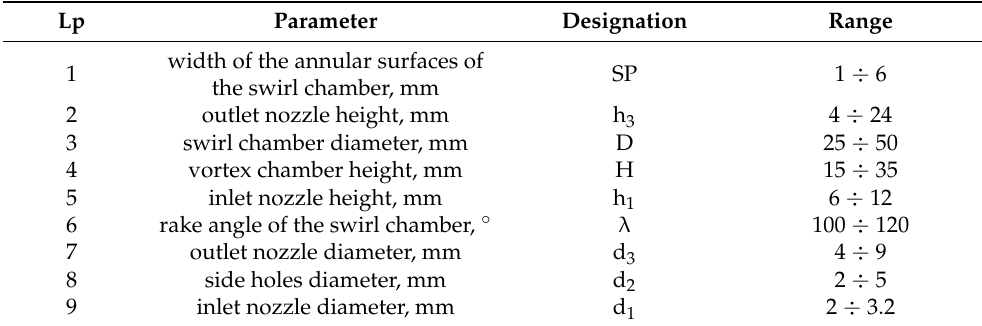
Table 4. Geometric parameters of the self-excited pulse head taken into account during the optimiza- tion process of the selected solution.